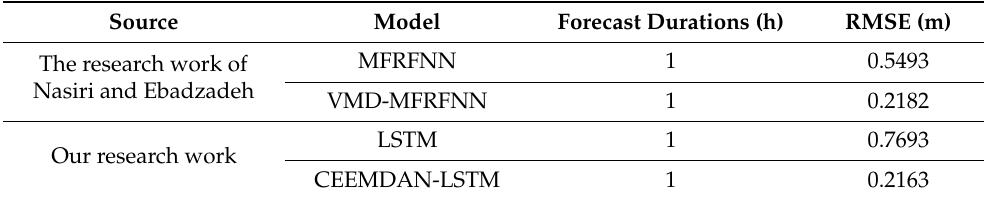
Table 7. Comparison of the performance of CEEMDAN-LSTM with other